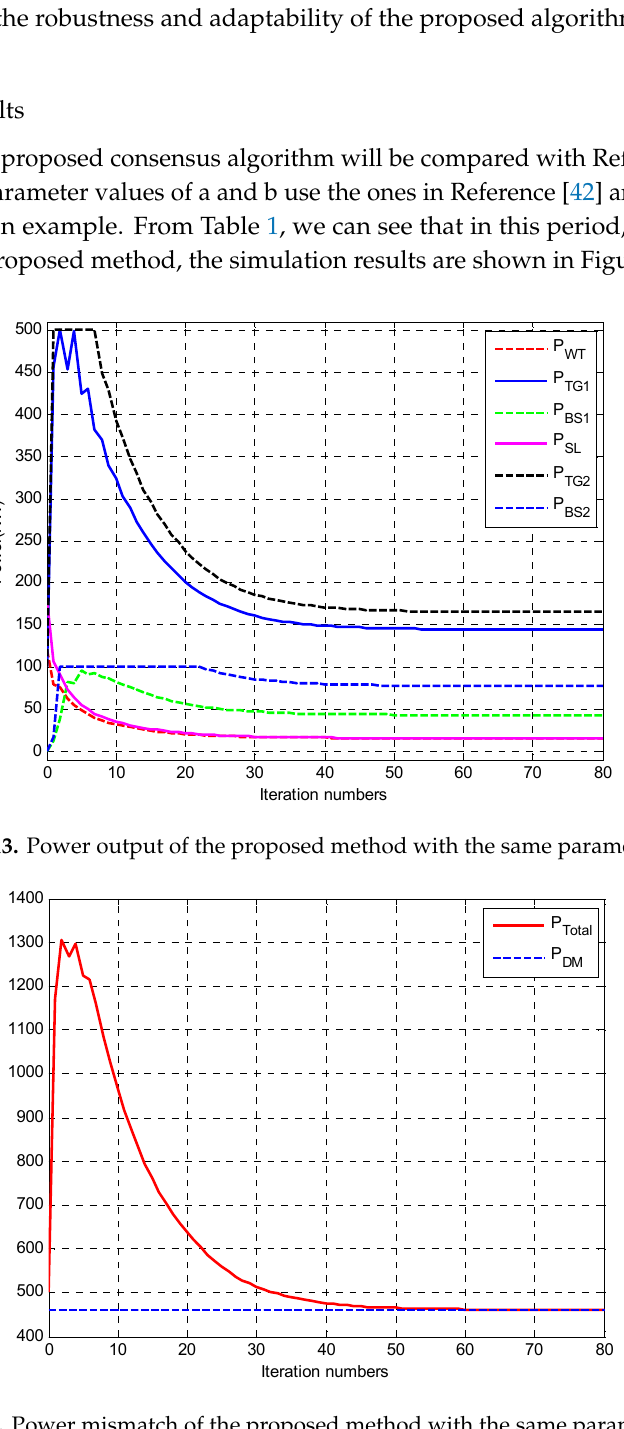
Figure 14. Power mismatch of the proposed method with the same